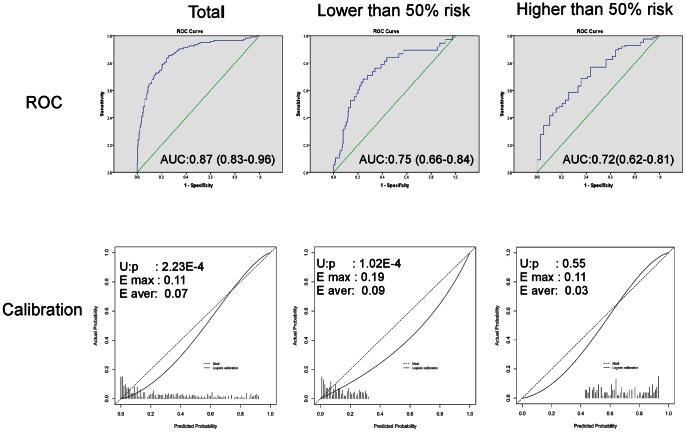
ROCs and calibrations of the total and 50% cut point subgroups of patients.The AUC of the total nodules was 0.87 (range, 0.83 to 0.90), but the calibration showed significant difference between the observed frequencies and predictive probabilities (p = 2.23*10−4). Based on the calibration plot, we used 50% as the threshold to divide the nodules into low risk and high-risk groups. In the low-risk group, the AUC was 0.75, and the calibration p-value was 1.02*10−4. But in the high-risk group, the AUC and calibration p-value were 0.72 and 0.55 respectively, which showed a good performance of the nomogram.